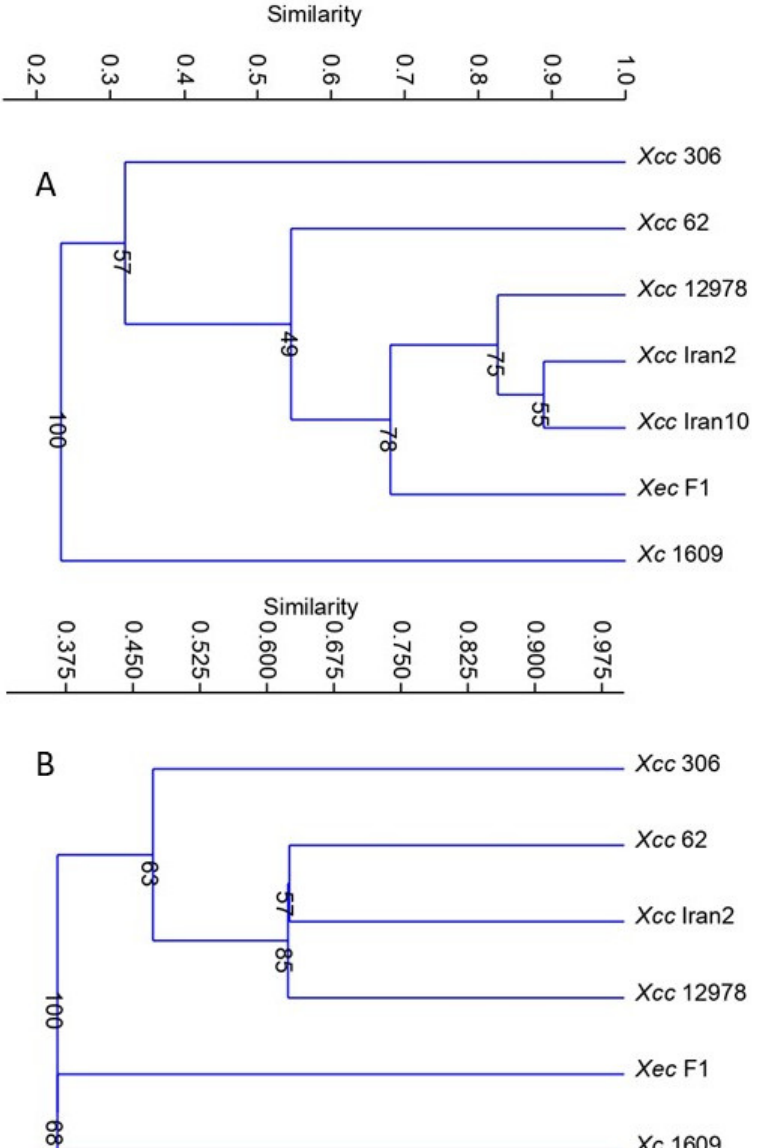
Figure 1. Dendrograms showing relationships among Xanthomonas strains based on data from ( A ) Biolog GN2 activity and ( B ) chemotaxis assay.